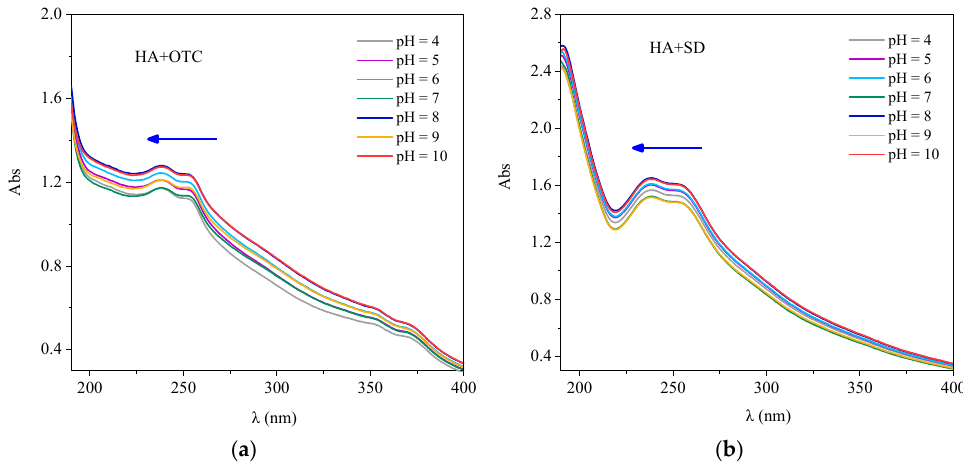
Figure 7. The interactions of OTC and SD with HA under different pH conditions. ( a ) OTC; ( b ) SD.